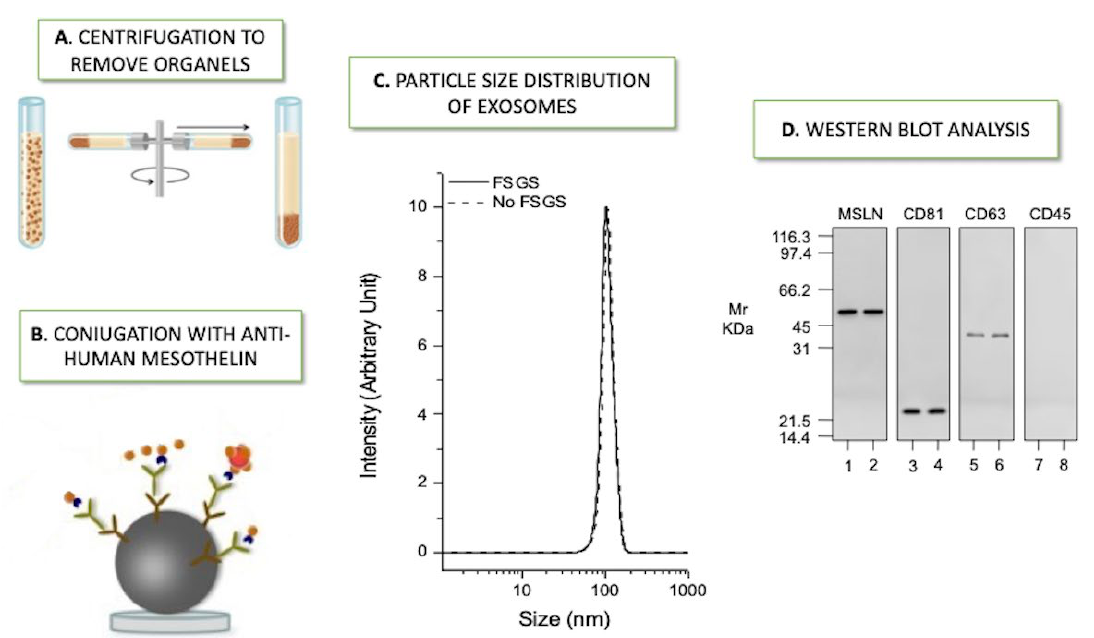
Figure 2. Isolation and characterization of mesothelial exosomes. Steps of the isolation and characterization of mesothelial exosome from peritoneal dialysis effluent: ( A ) Aliquots underwent a series of centrifugation cycles to remove mitochondria, other organelles, and microvesicles to obtain a purified fraction of exosomes. ( B ) Enriched exosomes fractions were mixed with polyclonal biotin-conjugated anti-human mesothelin. ( C ) Exosome size was determined by Dynamic Light Scattering, revealing a Gaussian distribution profile with a typical mean peak at 100 ± 5 nm ( D ) Western blot analysis revealed that the exosomes of both groups were positive for mesothelin (MSLN), CD81, and CD63, but not for CD45 (FSGS = focal segmental glomerular